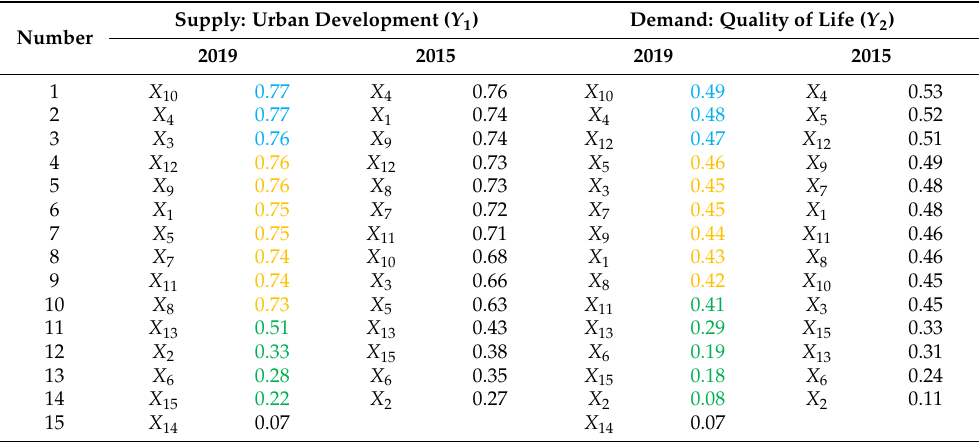
Figure 10. Analysis diagram of driving mechanism of urban green space change. Table 5. Classify the driving factors: blue represents “Key factors”, orange represents “Important factors”, and green represents “Auxiliary